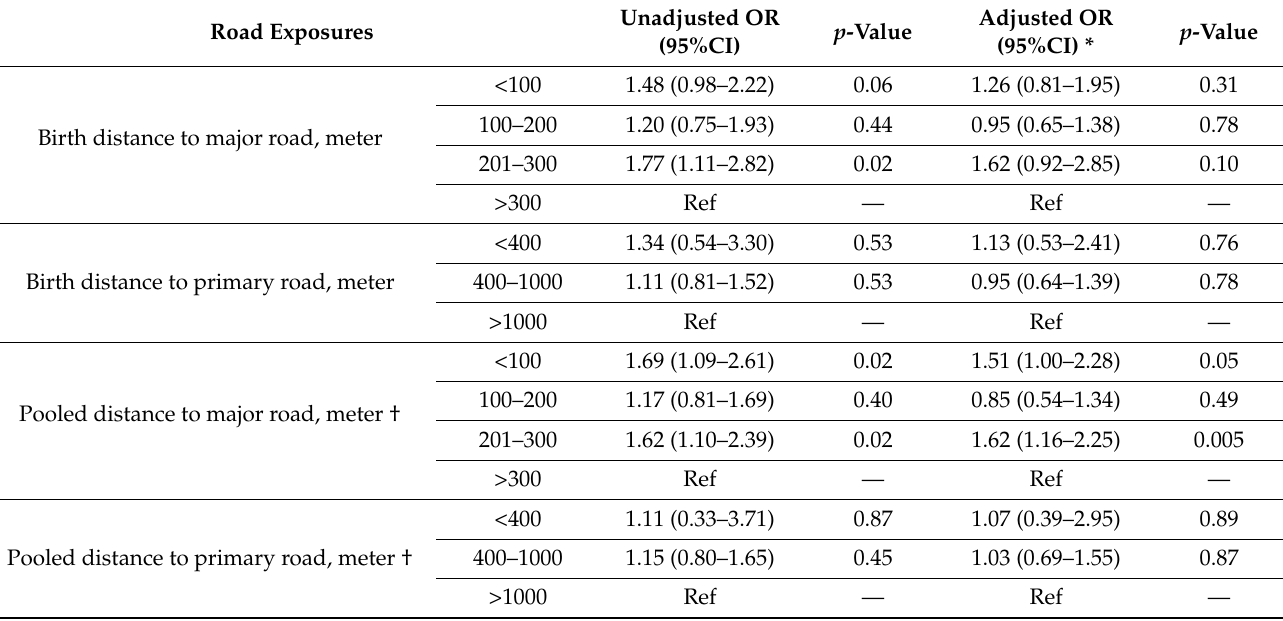
Table 6. Unadjusted and adjusted logistic regression models of road exposures for asthma by age 5 years as outcome. Road Exposures